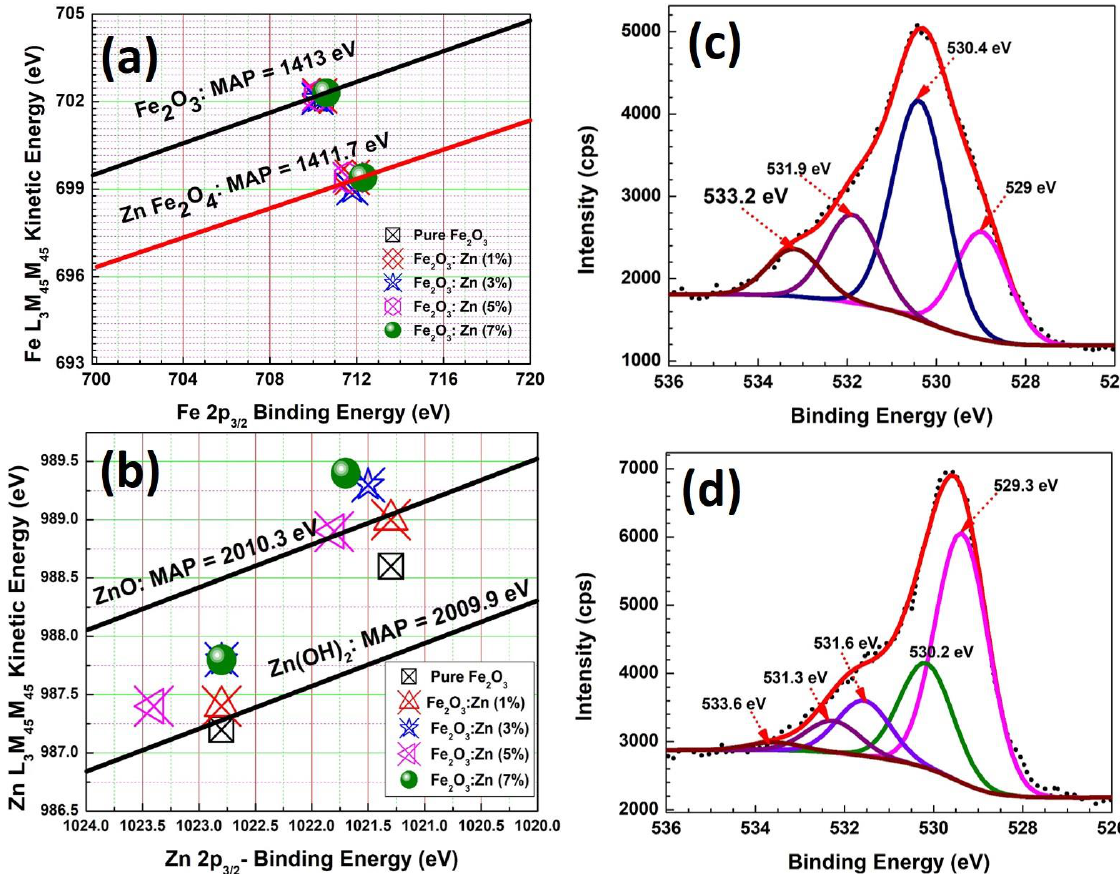
Figure 7. XPS spectra: ( a ) Wagner plots for Fe 2p; ( b ) Wagner plots for Zn 2p; ( c ) O − 1s for pure Fe 2 O 3 ; and ( d ) O − 1s for Fe 2 O 3 doped with Zn (7%). The modified Auger parameters (MAPs) were obtained at α = 2010.3 eV for ZnO